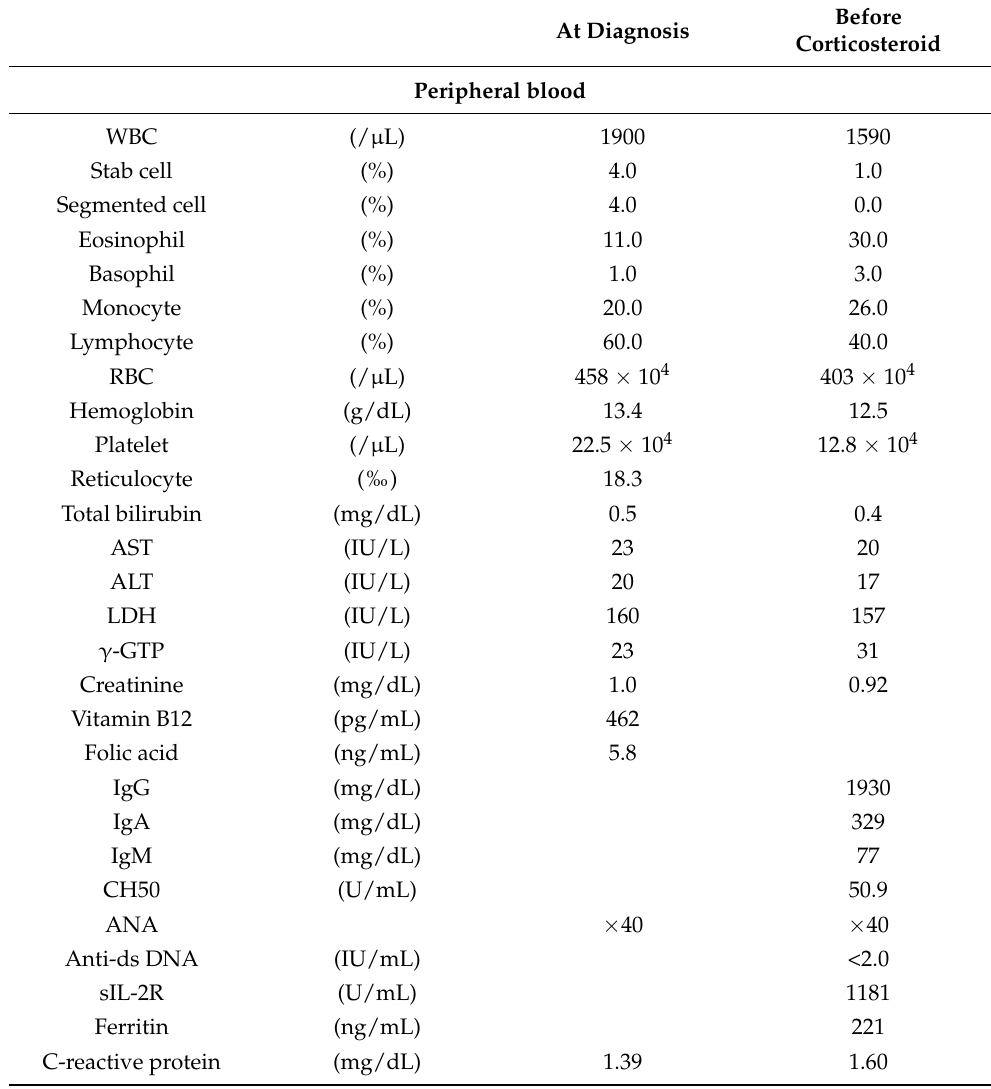
Table 1. Laboratory and bone marrow findings at the diagnosis and before corticosteroid therapy. Before At Diagnosis Corticosteroid Peripheral blood WBC (/ µ L) 1900